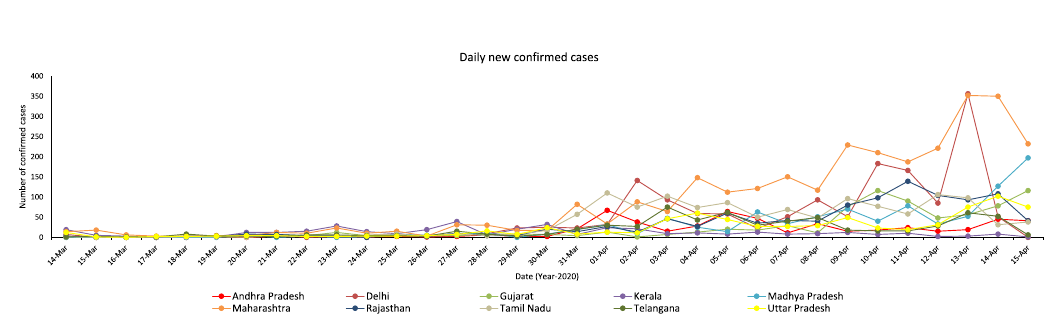
Fig. 4. Daily new confirmed cases of top-10 states of India from March 14, 2020 to April 15,